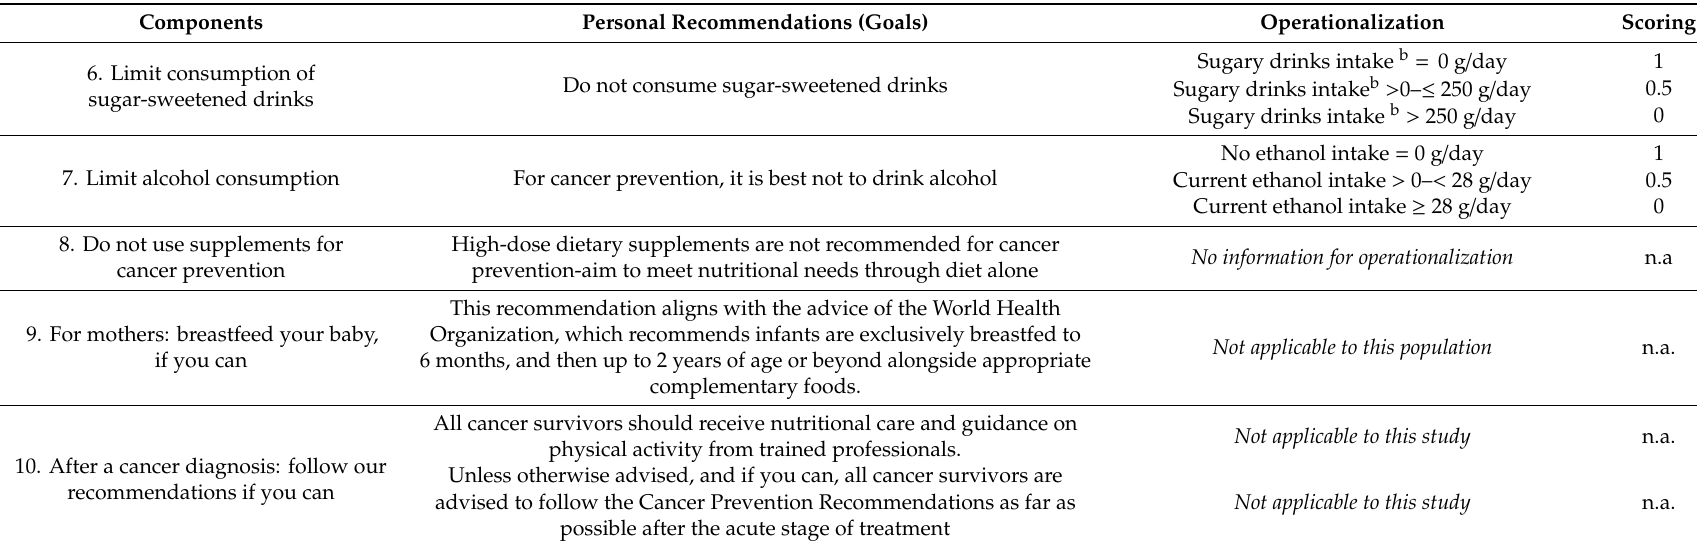
Table made from the information provided by Shams-White MM et al. 2019 [16] AICR, American Institute for Cancer Research; BMI, body mass index; PA, physical activity; WC, waist circumference; WCRF, World Cancer Research Fund. a Fruits and vegetables excluding starchy vegetables (sweet potatoes), canned fruit, dried fruit, and fruit juices. b Sugary drinks included both sugar-sweetened soft-drinks and commercial fruit and vegetable